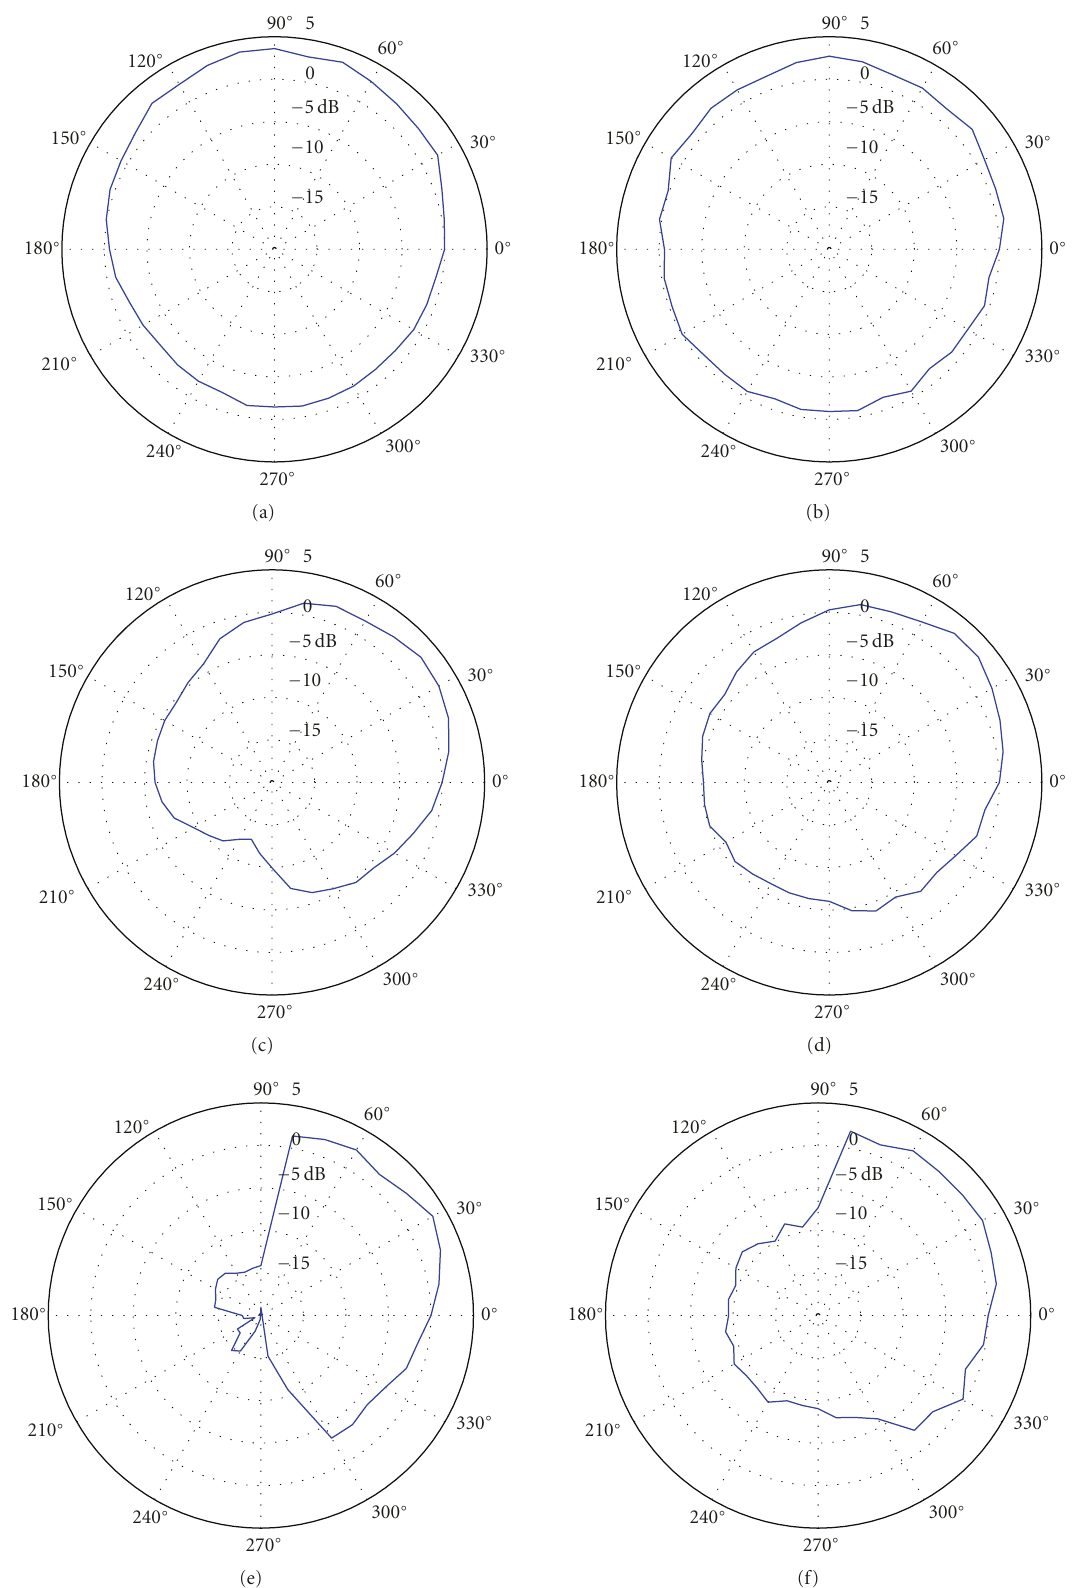
Figure 6: Polar plots of device performance in three di ff erent modes. The behind-the-ear unit with the microphones is mounted at the left side (90 ◦ ) of a KEMAR manikin, facing 0 ◦ . Top row: one-omnidirectional microphone. Middle row: fixed directional processing. Bottom row: adaptive beamformer. Left column: results from measurements in an anechoic chamber. Right column: results in reverberant